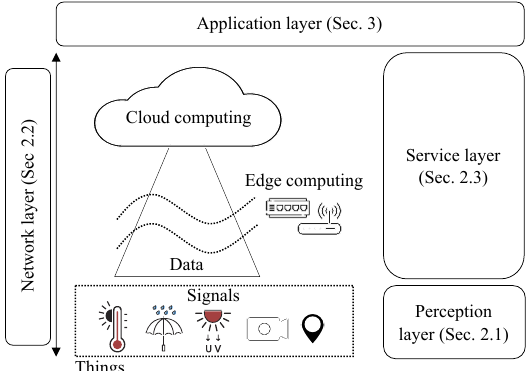
Figure 2. Architecture of an Internet of Things system (inspired by [27]); this also reflects the structure of the survey.